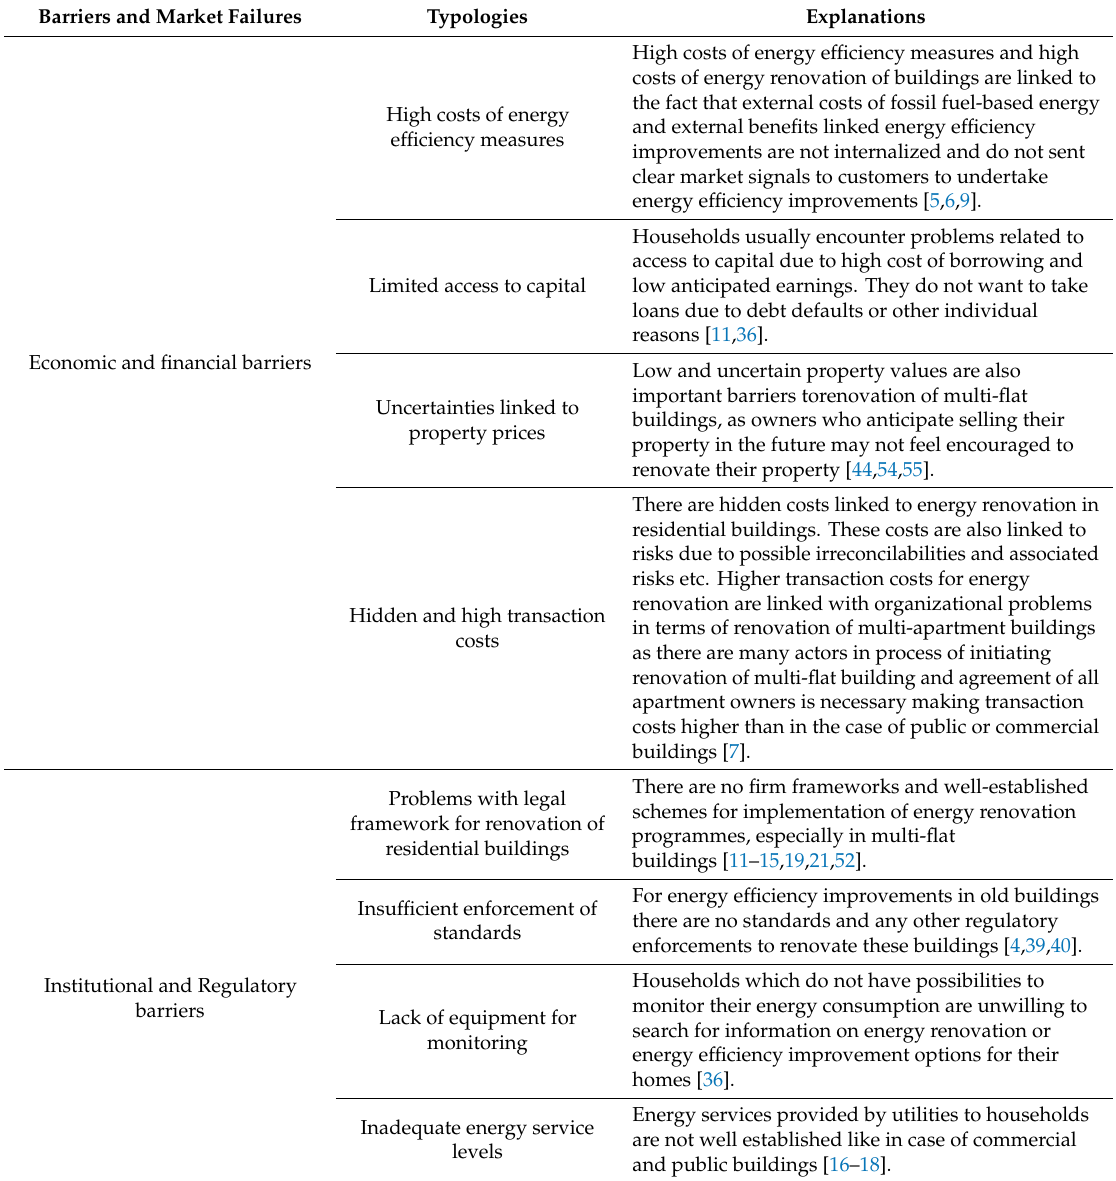
Table 1. Barriers and market failures linked to energy e ffi ciency improvement in